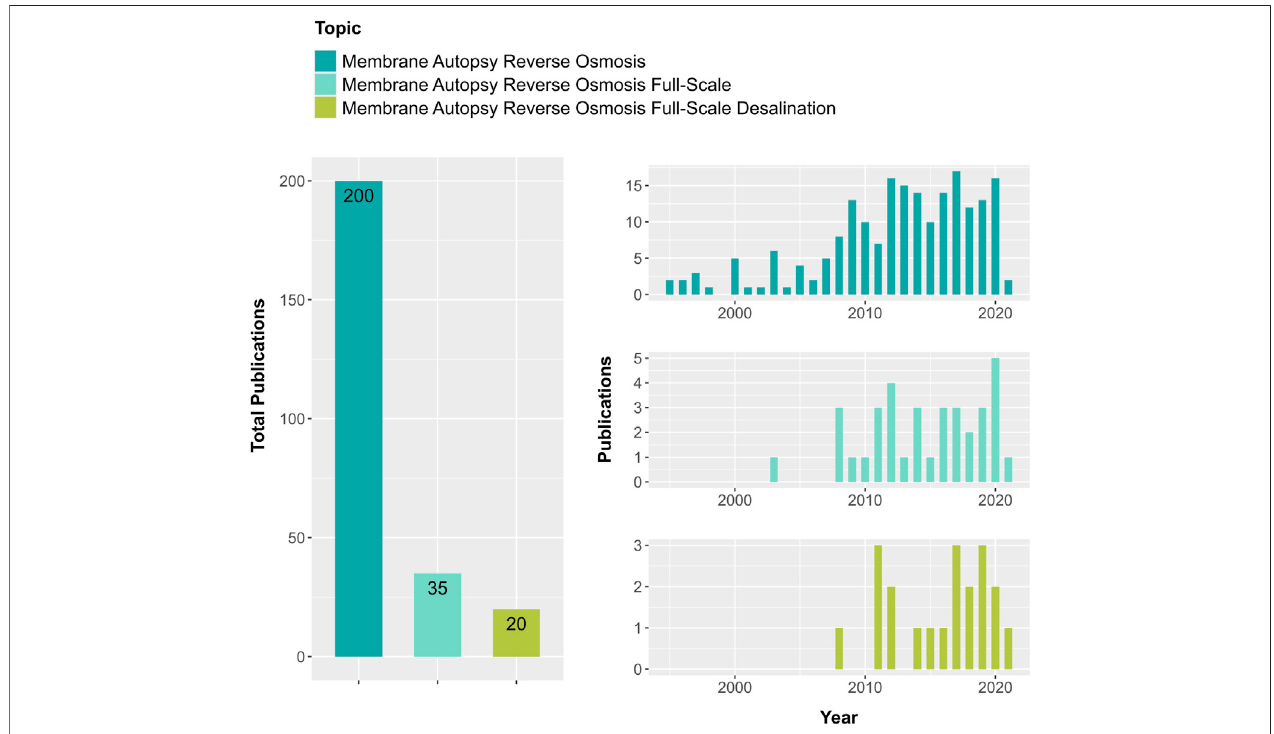
FIGURE1| Numberofpublicationrecordsretrieved fordifferentcombinedtopickeywordsfrom theWebofSciencedatabase when searchedfortheyear1995to February2021.Byincludingthewordsfull-scaleanddesalinationinthetopicofmembraneautopsyinreverseosmosis,thenumberofpublicationsdecreasedtentimes.